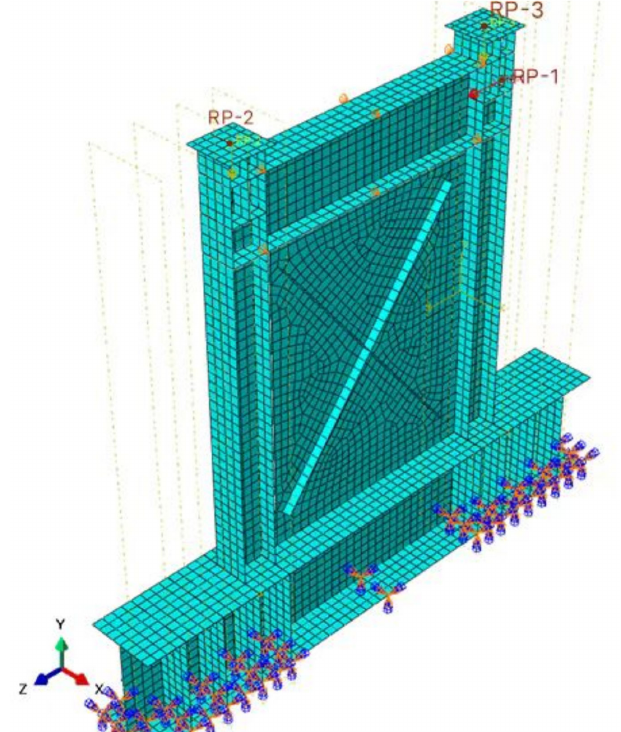
Figure 2. Finite element model of SPSW.